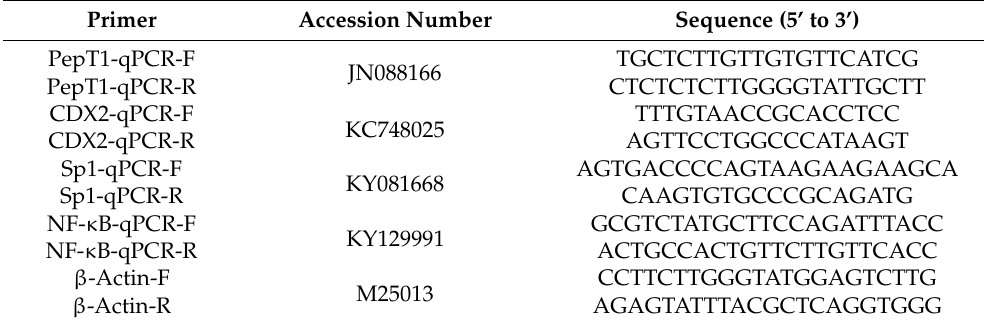
Table 2. Sequences of designed primers used in this study.